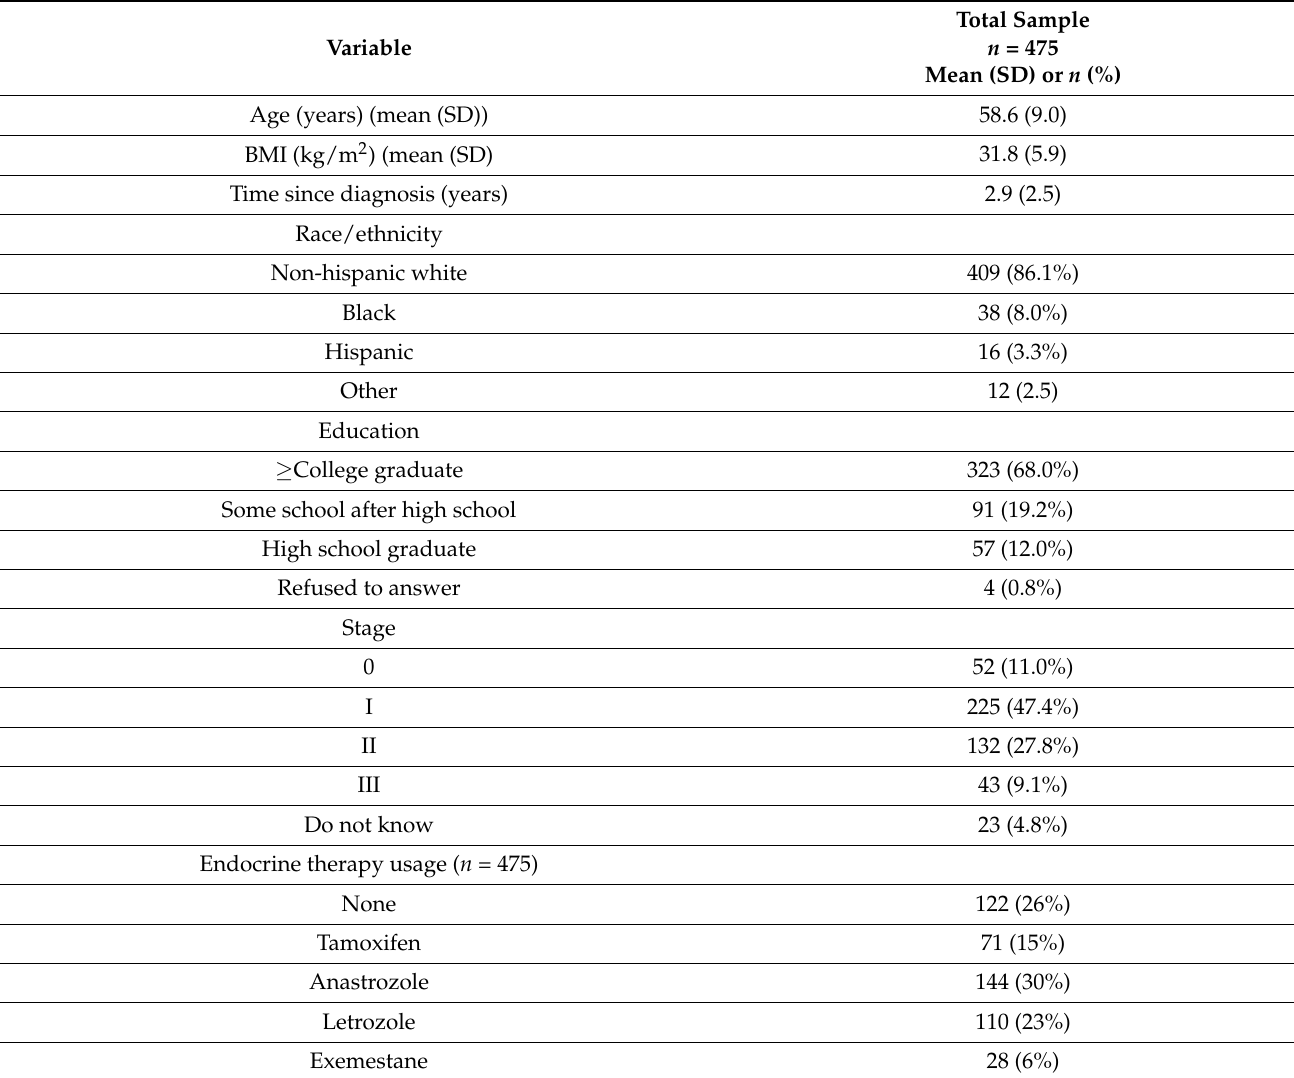
Table 2. Participant baseline